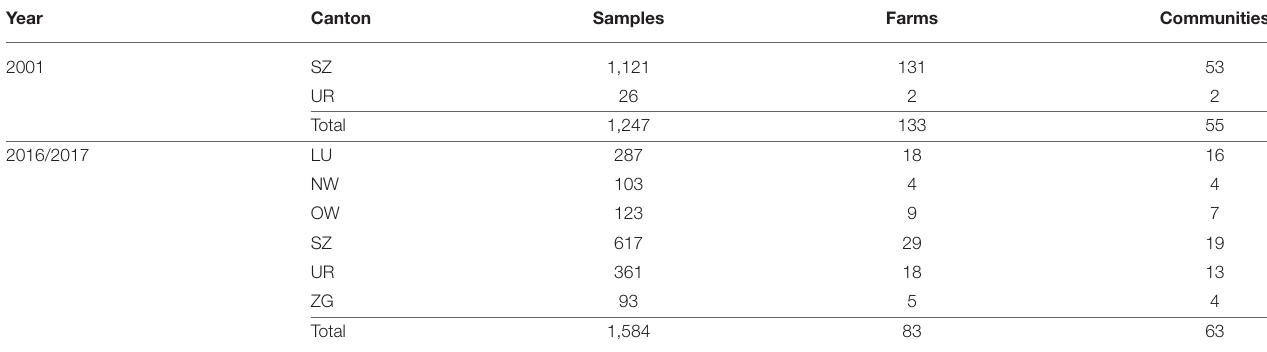
TABLE 1 | Number, year of sampling and origin of sheep sera analysed. Year Canton